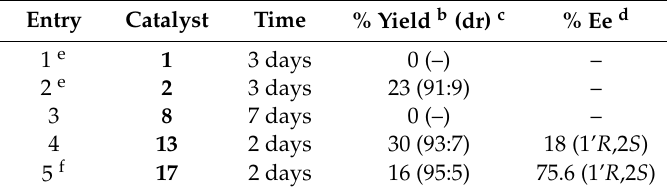
Table 3. Catalysis of the aqueous Michael addition of cyclohexanone to 2-nitrostyrene a . Entry Catalyst Time % Yield b (dr) c % Ee d 1 e 1 3 days 0 (–) – 2 e 2 3 days 23 (91:9) – 3 8 7 days 0 (–) – 13 2 days 30 (93:7) 16